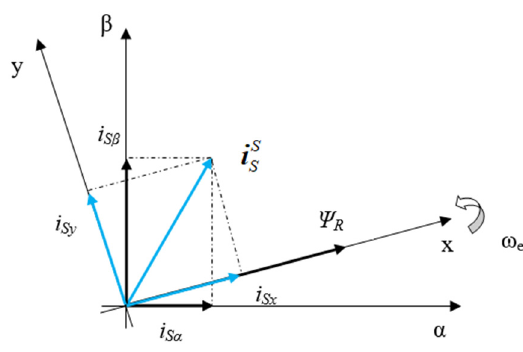
Figure 1. Current space vector decomposition.